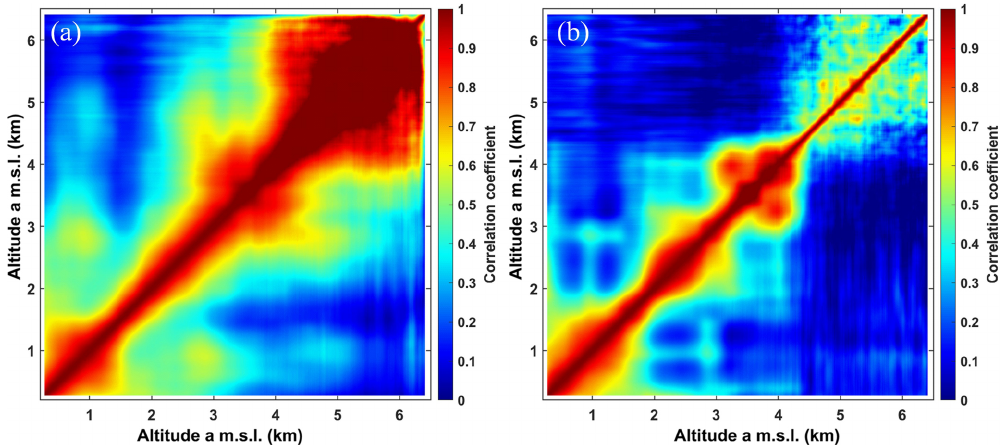
Figure 6. Lidar-derived correlation matrices for (a) the entire measurement period, between 24 June and 17 July 2014, and (b) the undisturbed period (without aerosol load anomaly in the free troposphere). These matrices are symmetric by